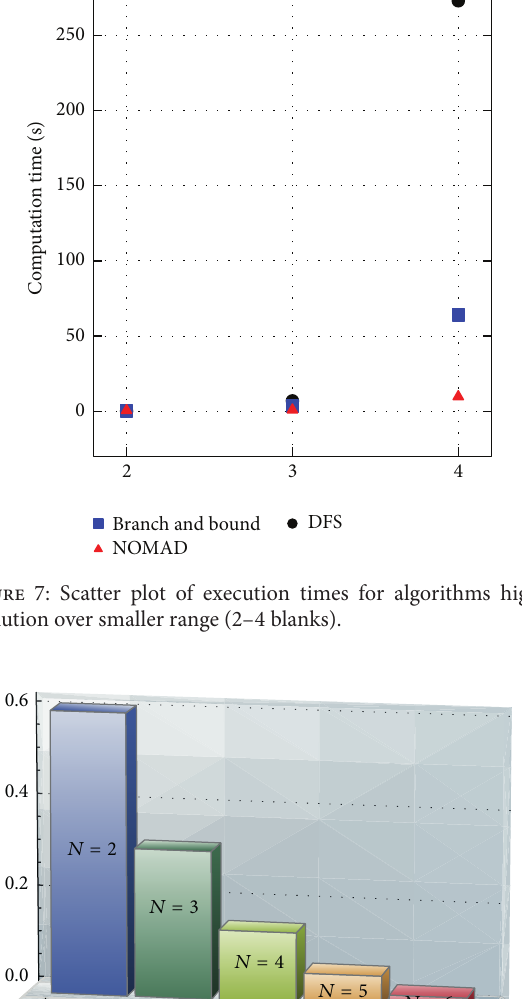
of the search space is being pruned. Figure 8 illustrates the fraction of the search space (leaf nodes) actually visited by the branch-and-bound method for different values of 𝑁 . Observe how this fraction decreases rapidly for different values of 𝑁 .